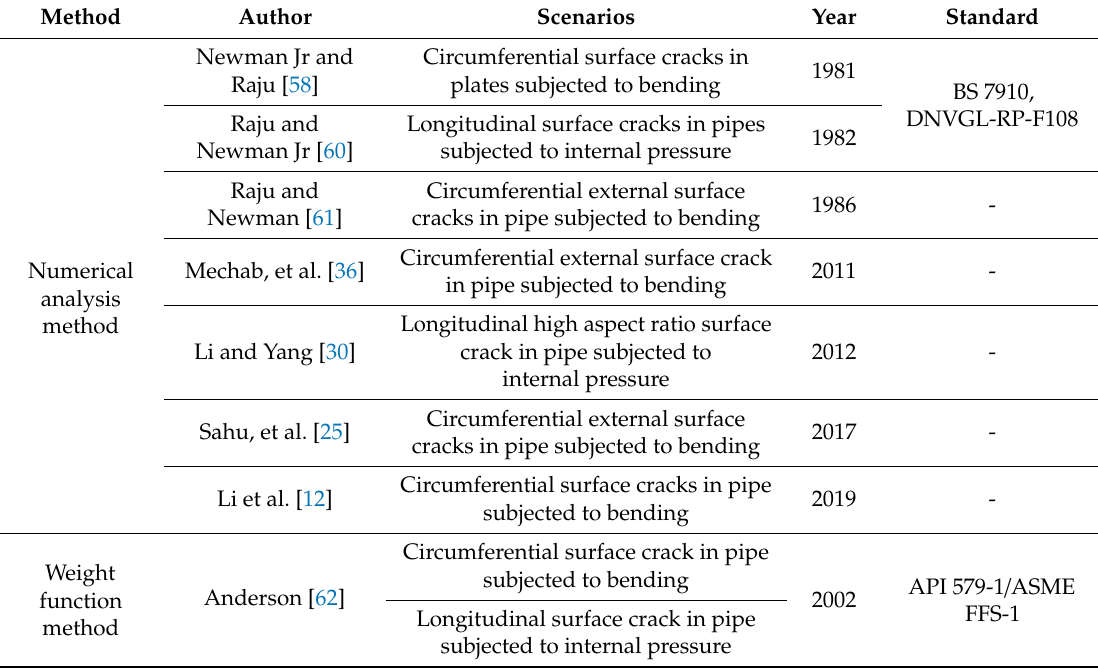
Table 4. Analytical methods of evaluating the Stress Intensity Factor (SIF) of surface cracks in metallic